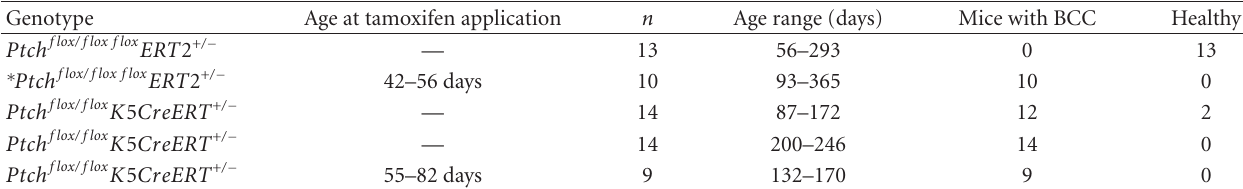
Table 2: BCC formation in Ptch flox/flox flox ERT 2 + / − and Ptch flox/flox K 5 CreERT + / − mice.